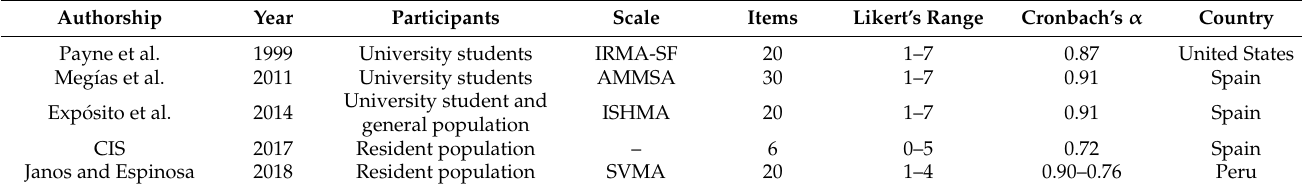
Table 1. Different scales used in the elaboration of the instrument 1